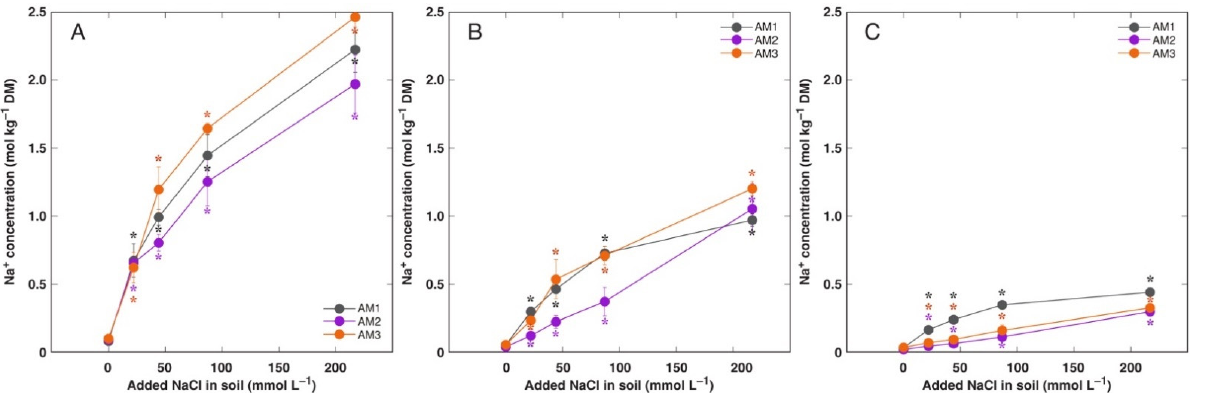
Figure 6. Effect of added NaCl concentration in soil on accumulation of Na + in old leaves ( A ), new leaves ( B ) and flowers ( C ) of Armeria maritima plants from different accessions after 7–8 weeks of cultivation. DM, dry mass. Data are means ± SE from 3 replicates. Asterisks of respective color indicate statistically significant differences ( p < 0.05) from control.